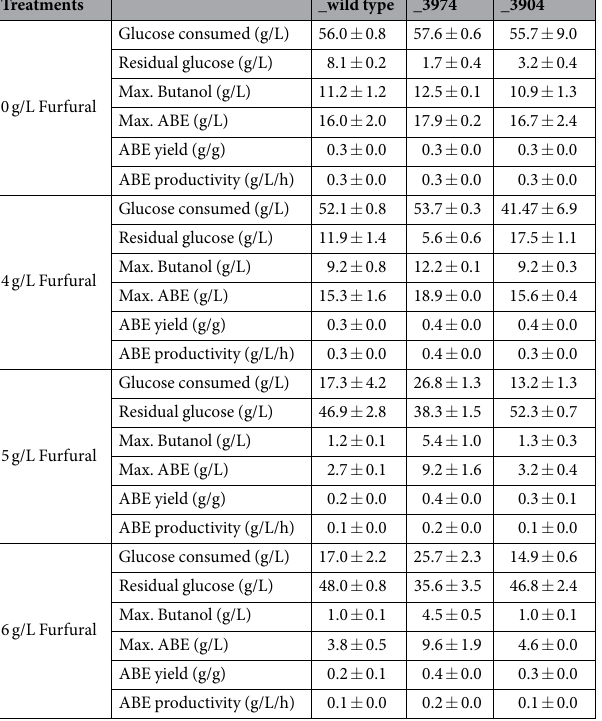
Table 2. Summary of the fermentation profiles of Cb _3974, Cb _3904 and Cb _wild type in Furfural (0–6 g/L)- challenged